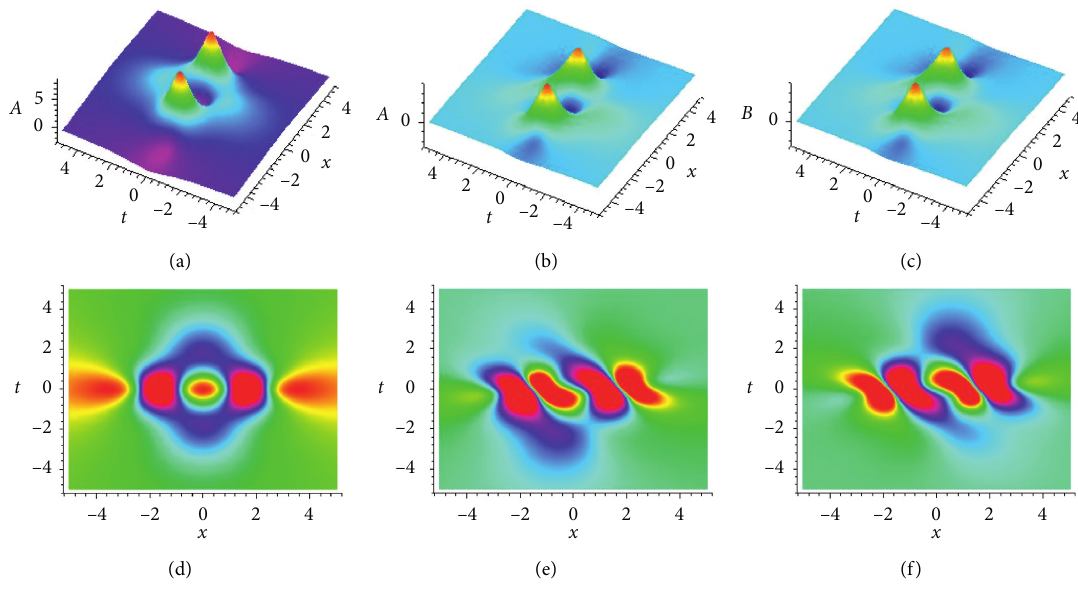
Figure 10: The second-order symmetry-breaking lump solution under the invariant condition F ( x, t ) � F (− x + x systems (7a) and (7b) with (a) b